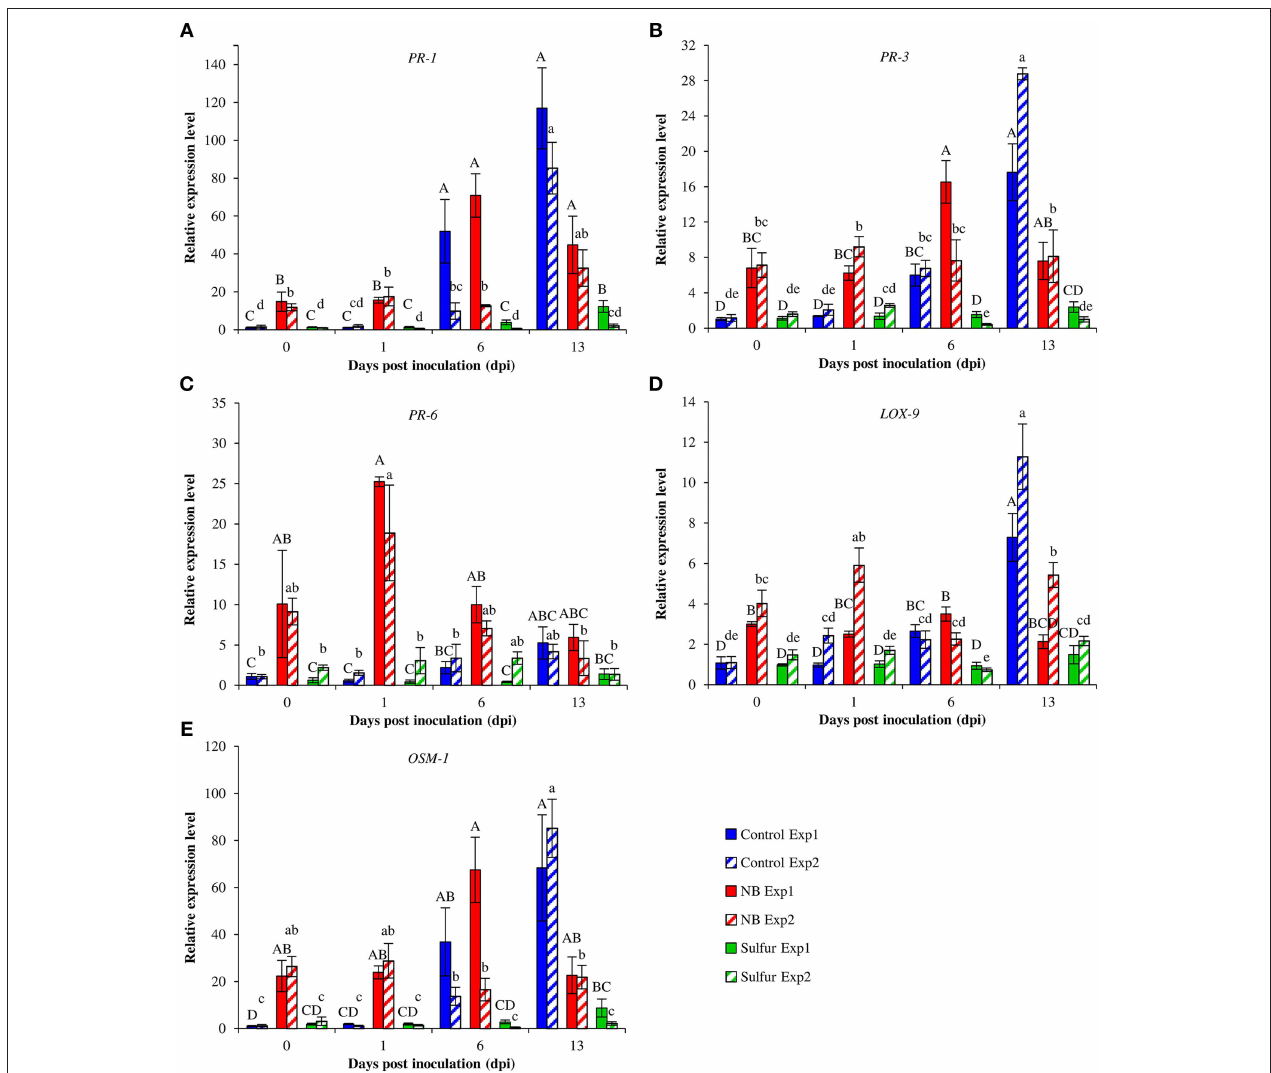
FIGURE 5 | Effect of nutrient broth on gene expression in grapevine plants under greenhouse conditions. Relative expression levels of genes encoding the pathogenesis-related protein 1 ( PR-1 ; A ), PR-3 (B) , PR-6 (C) , lipoxygenease 9 ( LOX-9; D ) and osmotin 1 ( OSM-1 ; E ). Grapevine plants were treated with water (Control), nutrient broth (NB) or sulfur (Sulfur), as standard fungicide, for 3 days before pathogen inoculation. Leaf samples were collected just before inoculation (0), at one (1), six (6) and 13 days post-inoculation (dpi). Relative expression levels were calculated using the γ -chain elongation factor 1 gene ( EF1- γ ) as constitutive gene for normalization, and data were calibrated on control plants collected at 0 dpi. For each time point, mean levels of relative expression and standards errors from three replicates (potted plants) are presented for each treatment and experiment. For each gene, uppercase and lowercase letters indicate significant differences among treatments and time points according to Tukey’s HSD test ( α = 0.05 ) in Experiments 1 (Exp1) and 2 (Exp2),